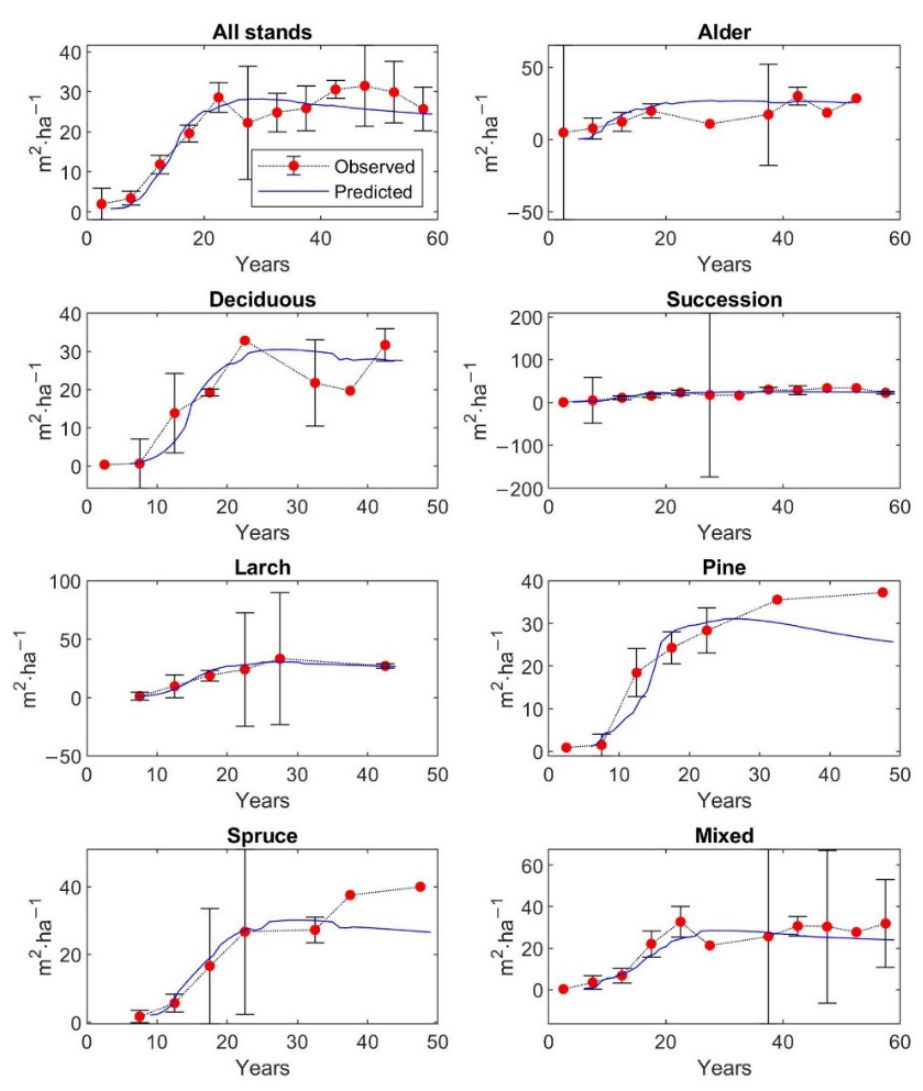
Figure A1. Verification of the model by the comparison of the observed 5-year average values with average predicted values of basal area, with a 95% confidence interval, according to individual forest types.